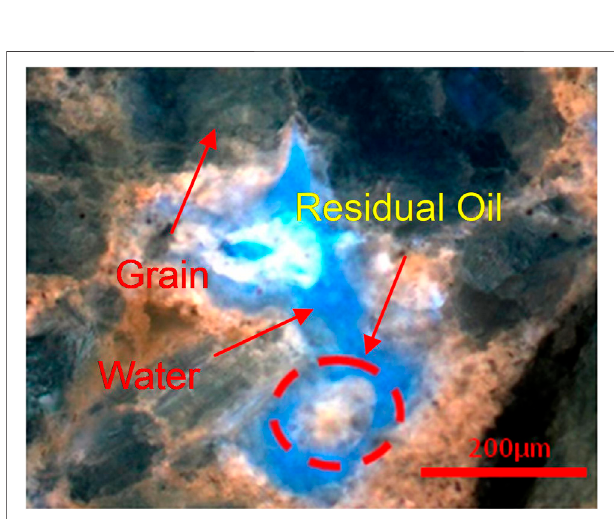
FIGURE 9 | Variation characteristics of permeability before and after ASP fl ooding.